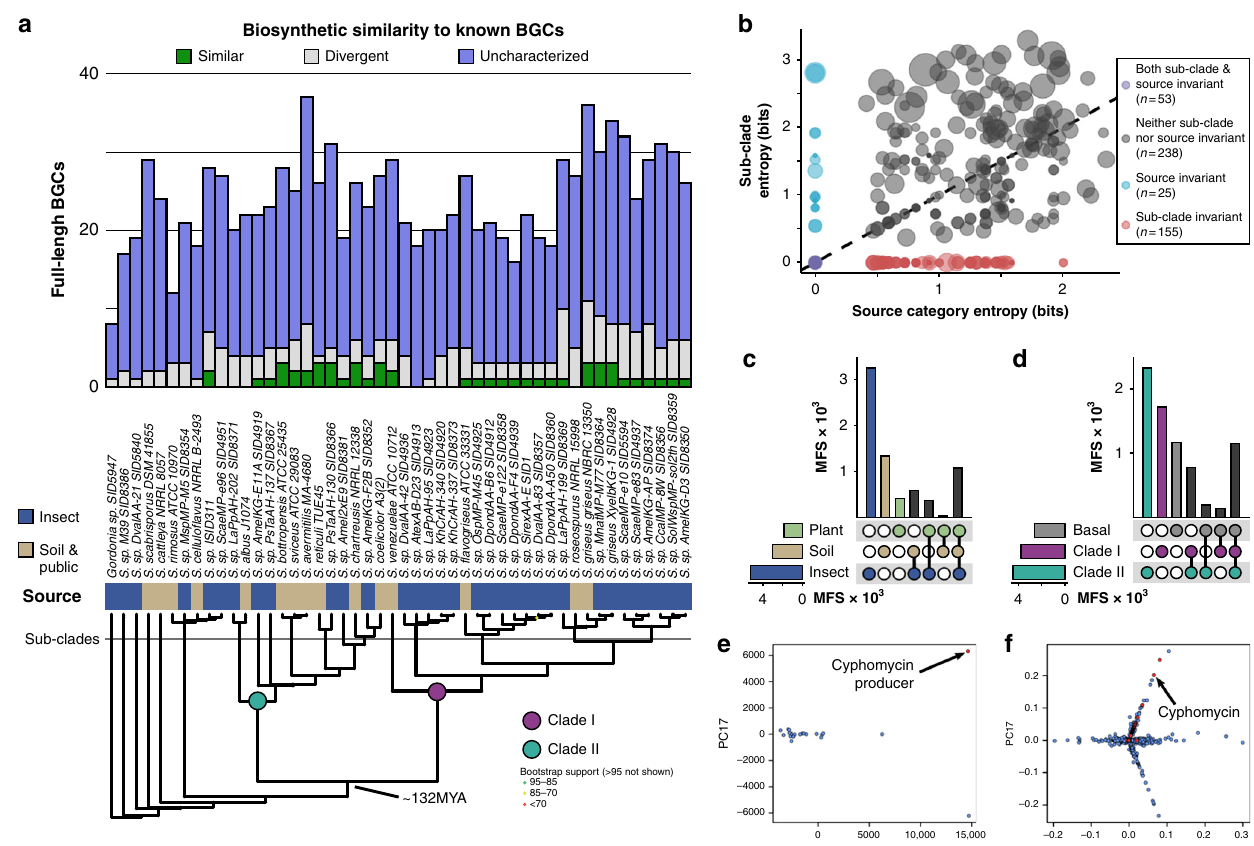
Fig. 4 Ecology and phylogeny in fl uence biosynthetic potential. a A core-genome phylogeny shows evolutionarily distinct lineages of Streptomyces associate with insects (subset shown, see Supplementary Figure 2). BGC similarity to known BGCs highlights the biosynthetic diversity of insect microbiome strains. b Source invariant (blue) and sub-clade invariant (red) BGC families suggest BGC presence is in fl uenced by both source and phylogeny. LC/MS metabolomics revealed MFs that are unique to c source and d phylogeny. e PCA of the metabolomes identi fi ed an outlier strain and f MFs that contribute to its uniqueness, including